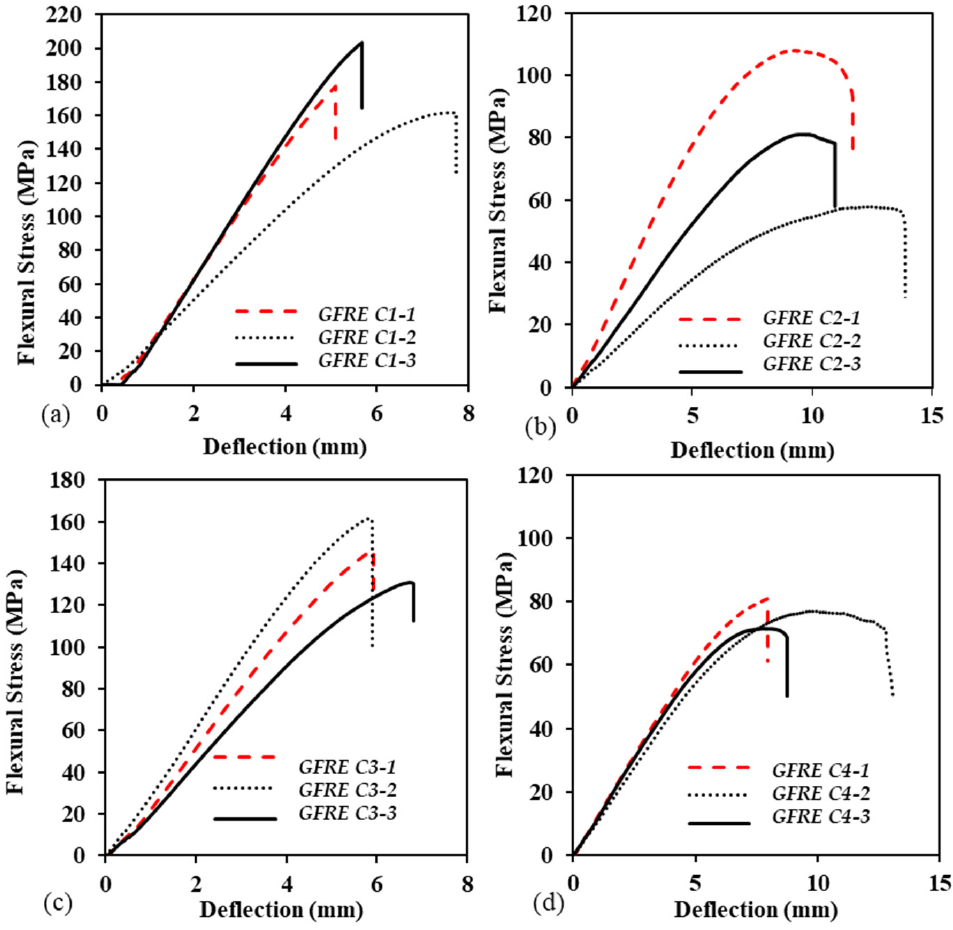
Figure 14. Flexural behaviour of GFRE under ( a ) C1, ( b ) C2, ( c ) C3, and ( d ) C4.